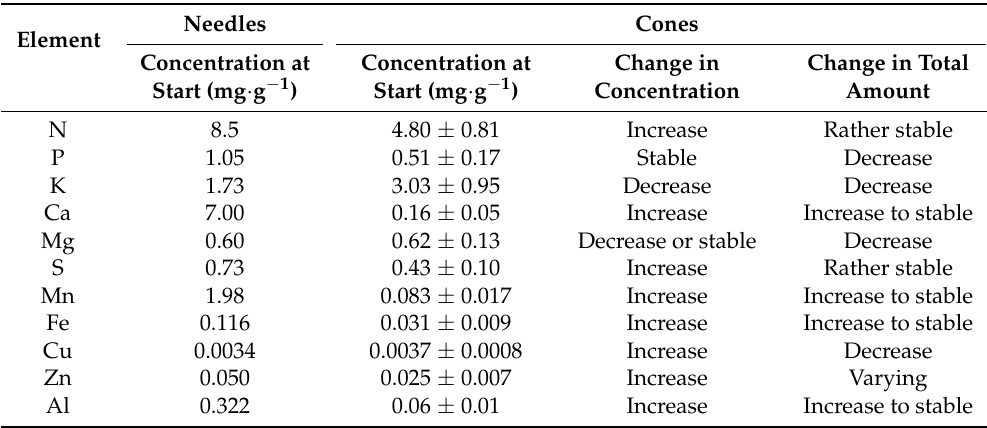
Table 3. Start concentrations of some elements in newly shed spruce needles (mean of two values) [6] and cones ( ± SD). For cones, main changes in concentration and total amount during 13 years of decomposition are indicated. Modified from